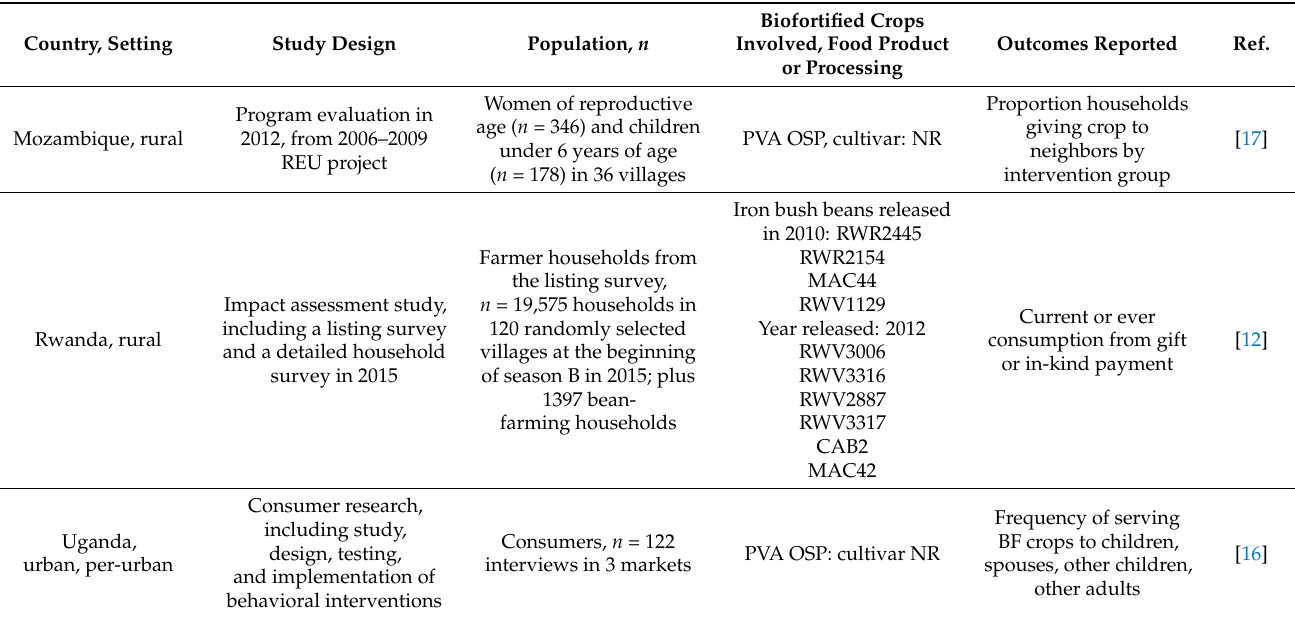
Table 4. Characteristics of included studies for Impact Pathway 2, Indirect